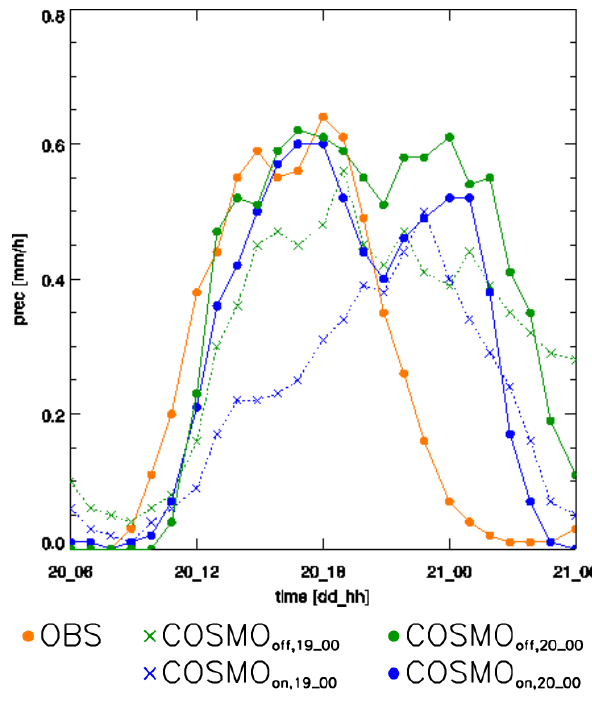
Fig. 8. Diurnal cycle of averaged precipitation in the area of Ger- many from 06:00 UTC 20 to 06:00 UTC 21 July 2007, as observed and simulated by different COSMO simulations.